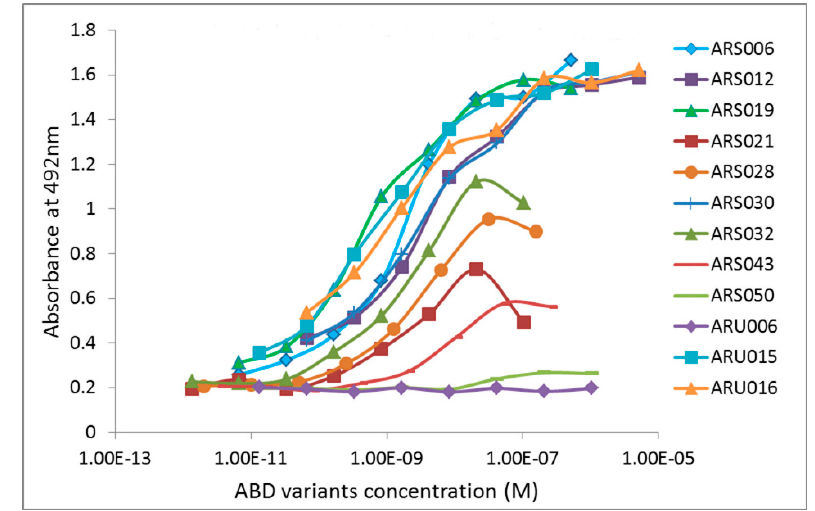
Figure 1. Screening of the interleukin 17 cognate receptor A (IL-17RA)-binding variants in enzyme-linked immunosorbent assay (ELISA). Bacterial cell lysates of individual ARS and ARU clones were screened for binding to the immobilized recombinant IL-17RA receptor. The binding proteins were produced in the form of in vivo biotinylated ARS/ARU-TolA-AVI fusion proteins and their binding to IL-17RA was visualized by streptavidin-HRP conjugate.